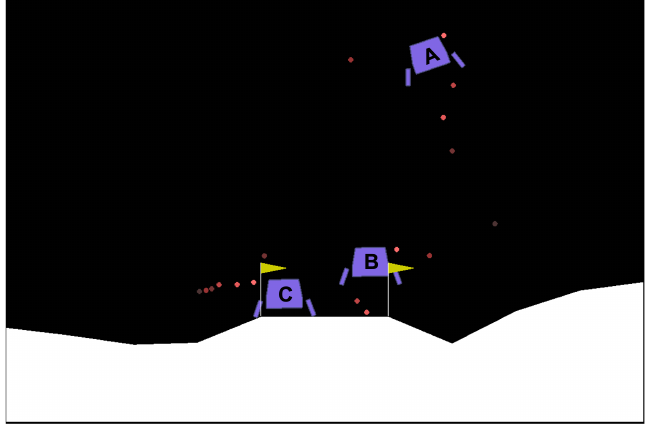
Figure A6. The illustration of the Lunarlander environment from openAI gym where the lunar lander (purple) has to land in the middle of yellow flag. A, B, and C are the three states showing the initial,middle, and final phase of the landing process,